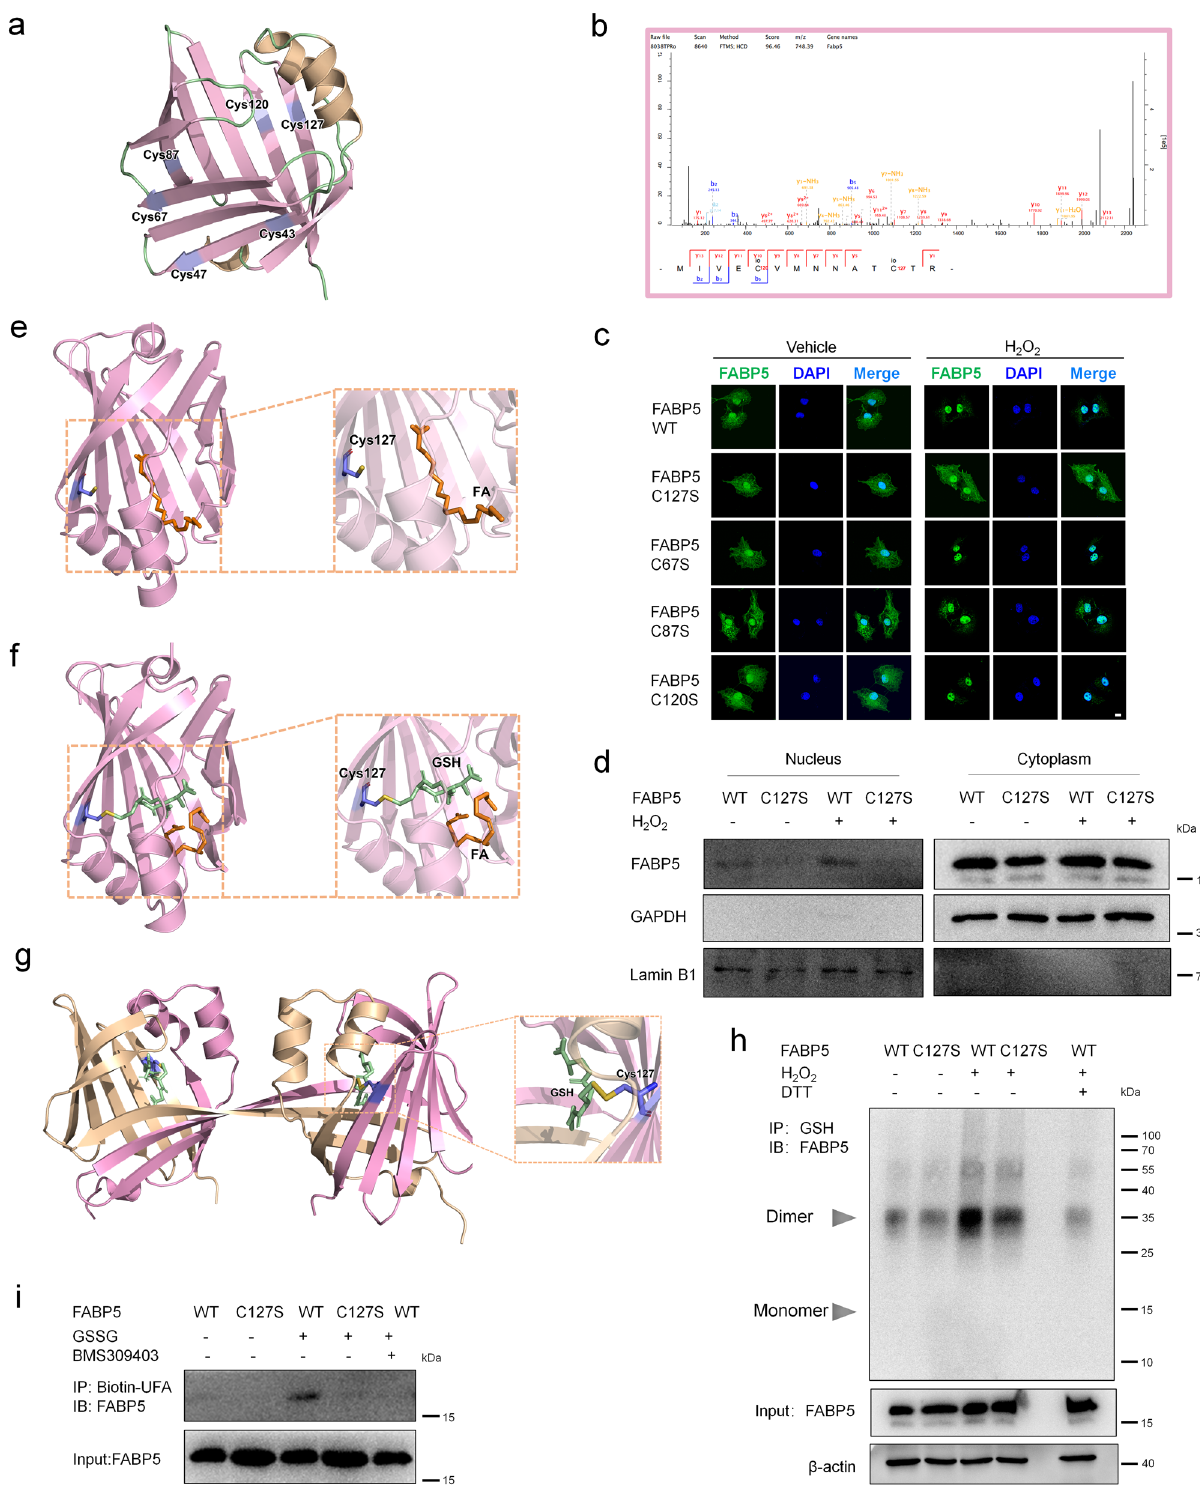
to Ser (FABP5 C127S) blocked the H 2 O 2 -induced nuclear translocation of FABP5 in COS-7 cells. In addition, the same result was obtained in the nuclear components of COS-7 cells overexpressing FABP5 C127S (Fig. 6d), while the mutation of Cys120 to Ser did not block the nuclear translocation of FABP5 induced by H 2 O 2 (Supplementary Fig. 7b). On the other hand, Homo sapience FABP5 structural data (PDB: 4LKT) showed that Cys127 is located within the ligand-binding pocket, indicating